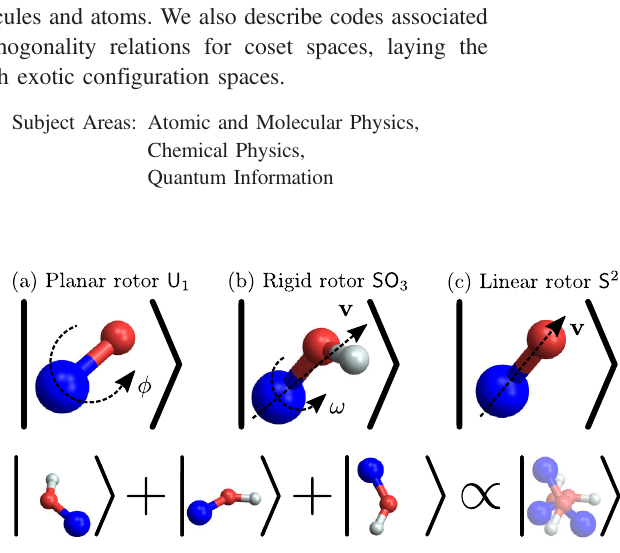
FIG. 1. Rigid bodies. A molecular code protects against errors in the orientation and angular momentum of a rigid body, which may be (a) a planar rotor whose orientation is an element of the two-dimensional rotation group U 1 , (b) a rigid rotor whose orientation is an element of the three-dimensional rotation group SO 3 , or (c) a linear rotor whose orientation is a point on the two- sphere S 2 . A basis state for the code, or code word, is a superposition of a finite number of